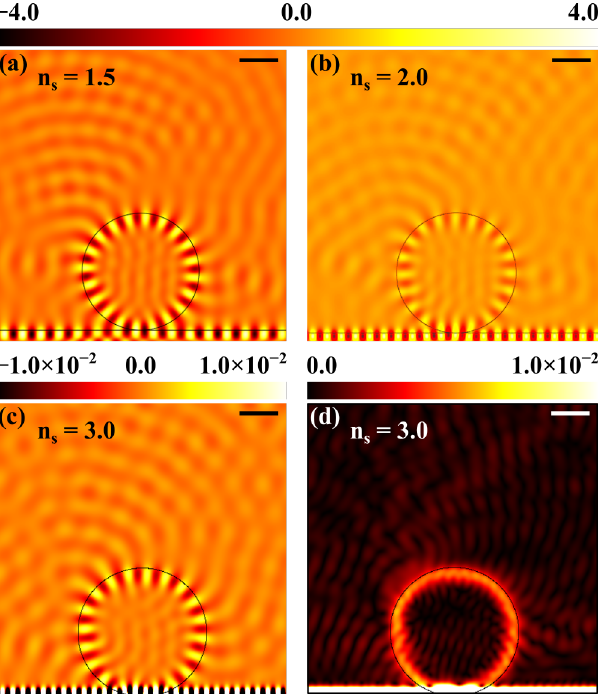
Figure 4. Conversion of an evanescent wave in a propagative wave by a glass microsphere. Real parts of the electric field distributions when ( a ) n s = 1.5, ( b ) n s = 2.0 and ( c ) n s = 3.0. ( d ) Absolute value of the complex electric field distribution when n s = 3.0. Scale bars represent 1 µm. λ 0 = 600 nm, θ = 1 rad, ψ = 0 rad, D = 3